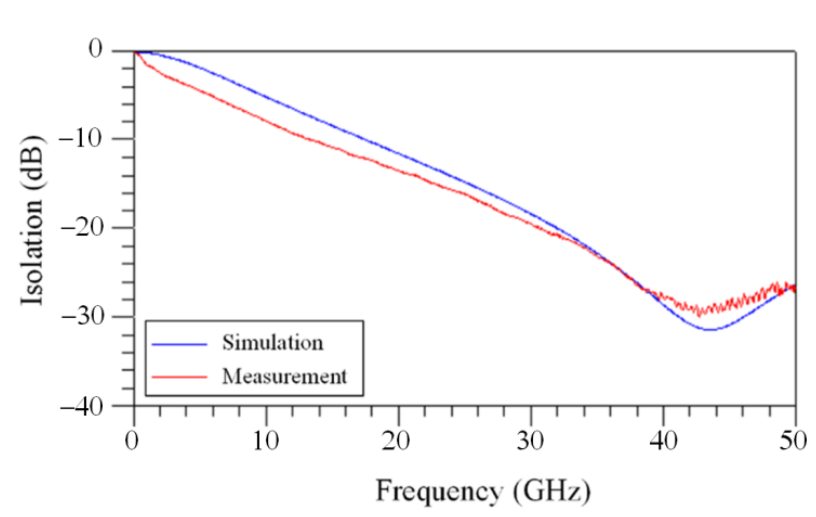
Figure 6. Insertion loss for the MSS.